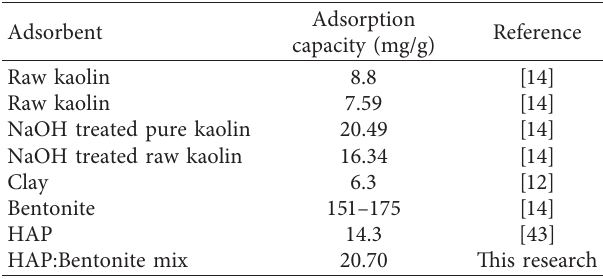
Figure 6: Effect of contact time on adsorption capacity for (a) 24mg combined adsorbent mass, (b) 34.5mg combined adsorbent mass, and (c) 33mg combined adsorbent mass. Table 2: Adsorption capacities for some related